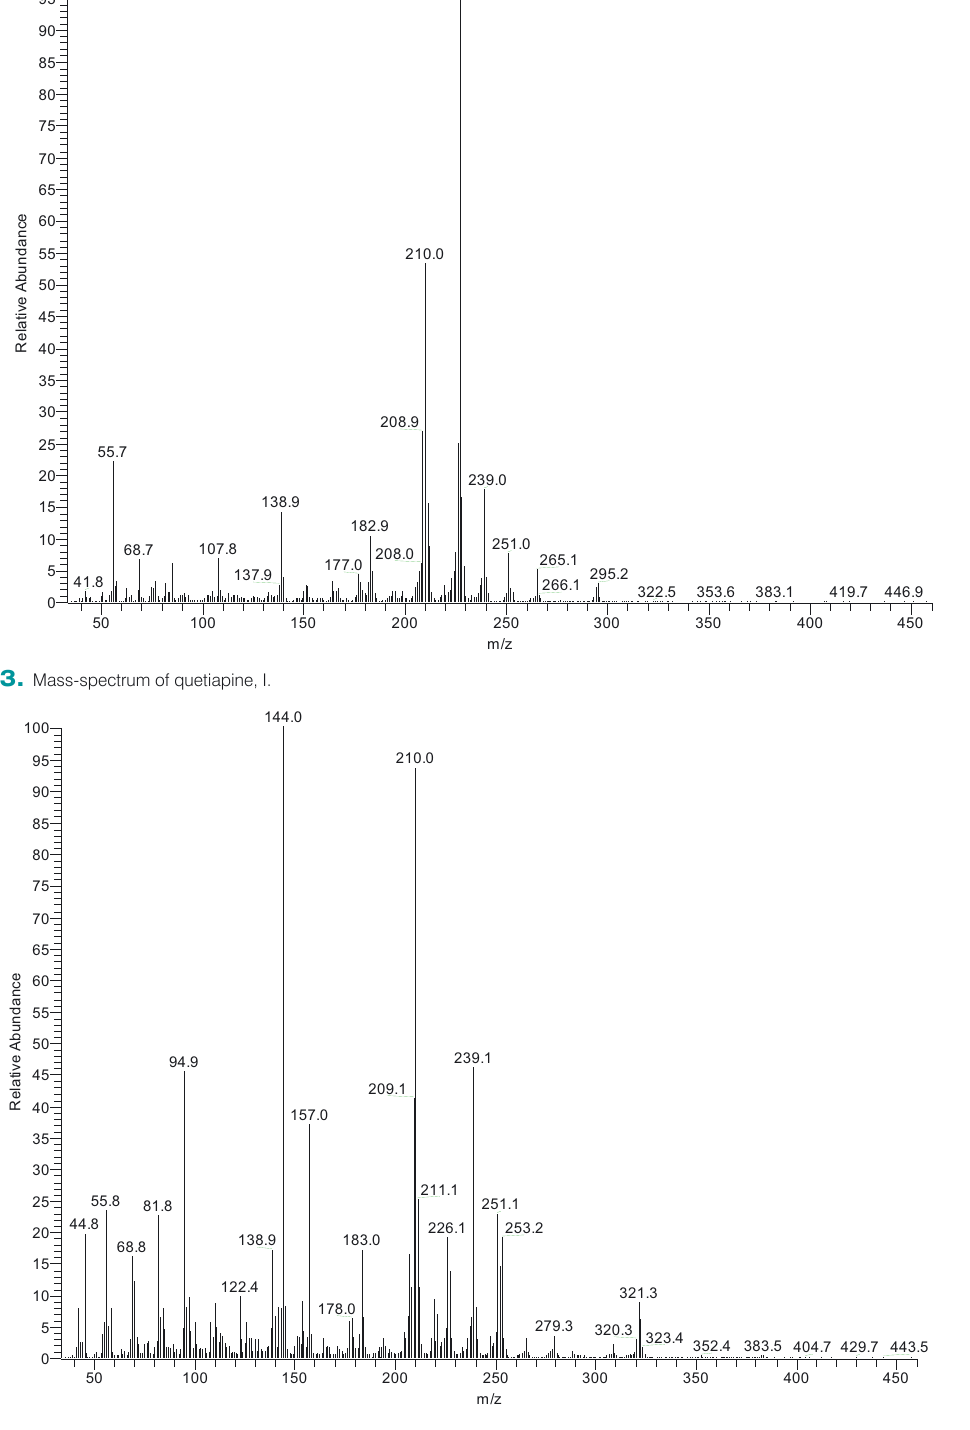
Figure 3. Mass-spectrum of quetiapine,